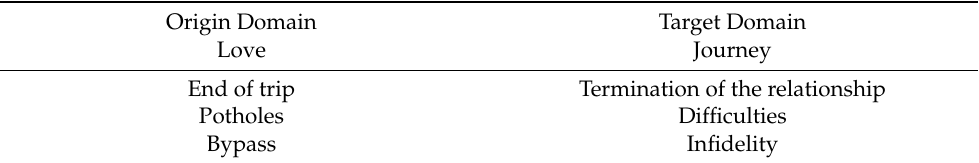
Table 1. Love is a